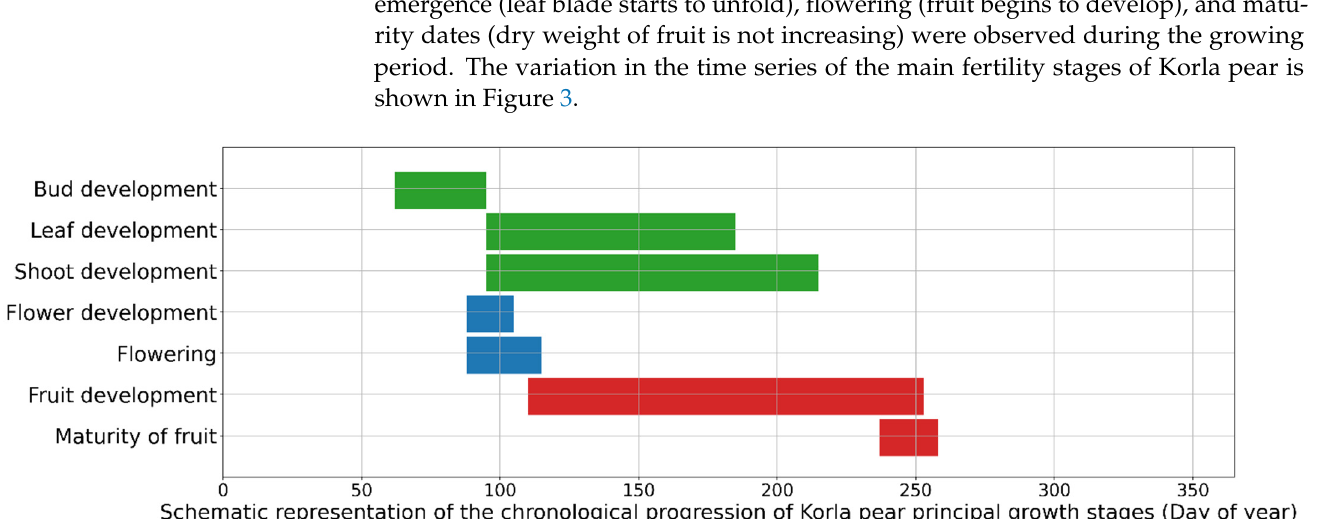
Figure 3. Main development stages of Kolar pear (day of year).